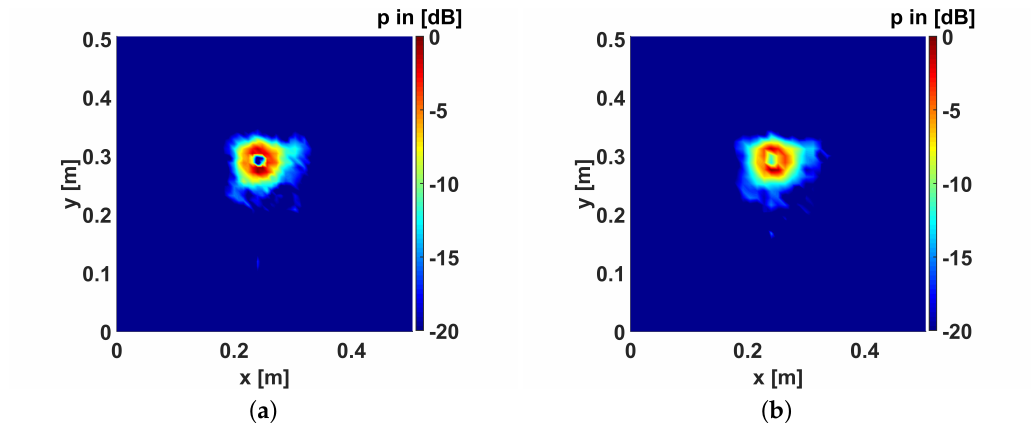
Figure 15. Amplitude at the top of the wooden particleboard with a ø20 mm piece of paper. Evaluated with the spec-radiation method, for the frequency 48–52 kHz, with ( a ) d x =d y =8 mm and